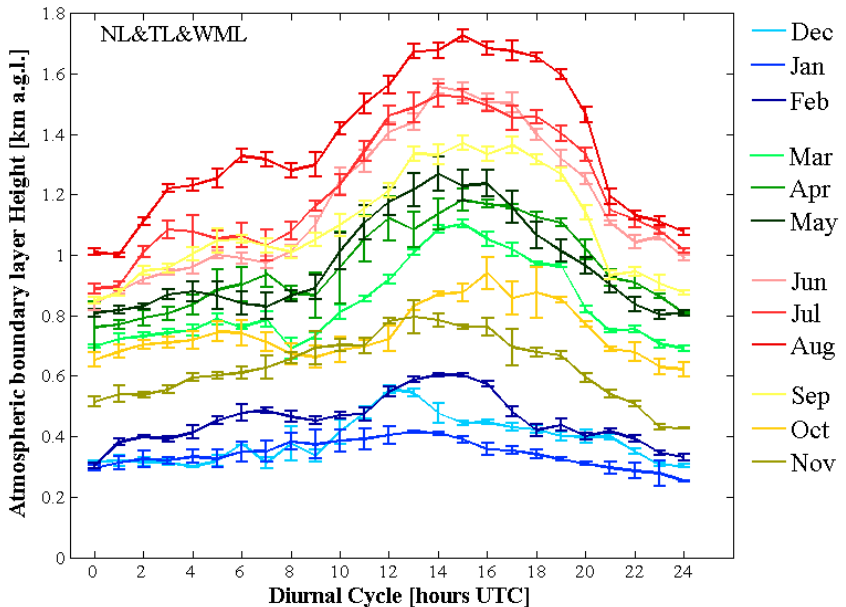
Figure 8. The average monthly diurnal cycles of the boundary layer height obtained from a subset of 346 clear-sky 24 h / day observations of the nocturnal layer (NL), transition layer (TL), and well- mixed layer (WML), in the years 2008–2018 in the city center of Warsaw, Poland. The ABLHs were obtained from the PollyXT lidar and CHM15k ceilometer signals using the wavelet covariance transform method (WCT). Merging and homogenization were applied to lidar data from November 2013 to December 2018. The months of each season are indicated in green for spring, in red for summer, in yellow for autumn, and in blue for winter. Temporal definitions of each season are given in Table 1.